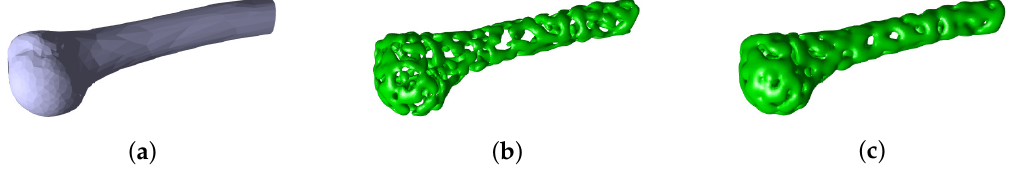
Figure 13. ( a ) Bone structure. ( b ) and ( c ) are snapshots of phase separation with average concentration function Equation (13) at t = 20 ∆ t and 40 ∆ t , respectively.